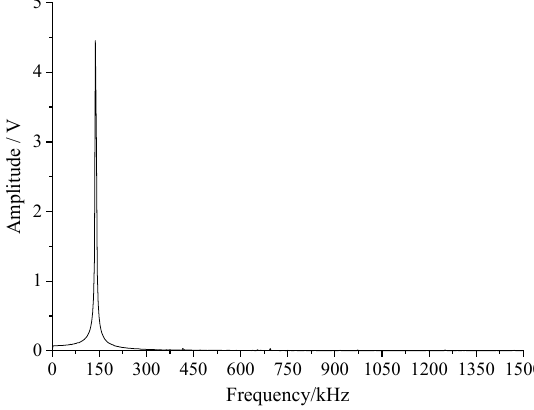
Figure 9. The spectrum of AW.